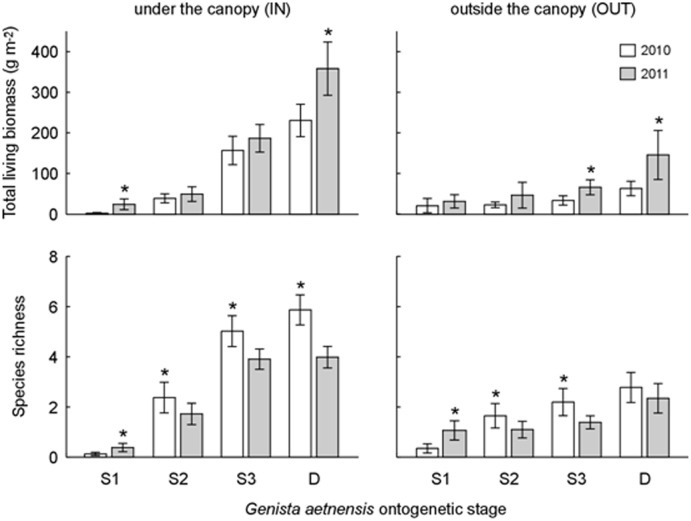
Yearly effects of Genista aetnensis on vegetation.Time-dependency of the effects of Genista aetnensis ontogenetic stage on plant living biomass (top) and species richness (bottom) under (left) or outside (right) the canopy of Genista individuals. Data refer to mean and 95% confidence interval of data recorded in two surveys in the years 2010 and 2011 (N = 60 for each bar). Significantly higher time-dependent values within each ontogenetic stage are marked with an asterisk (Post-hoc Duncan test at p<0.05, interactions of year and ontogenetic stage from GLMs in S10 Table).